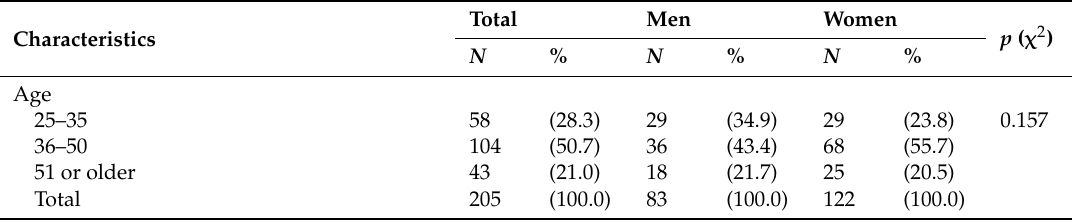
Table 1. Socio-demographic, socioeconomic and foreclosure process characteristics of sample by sex.